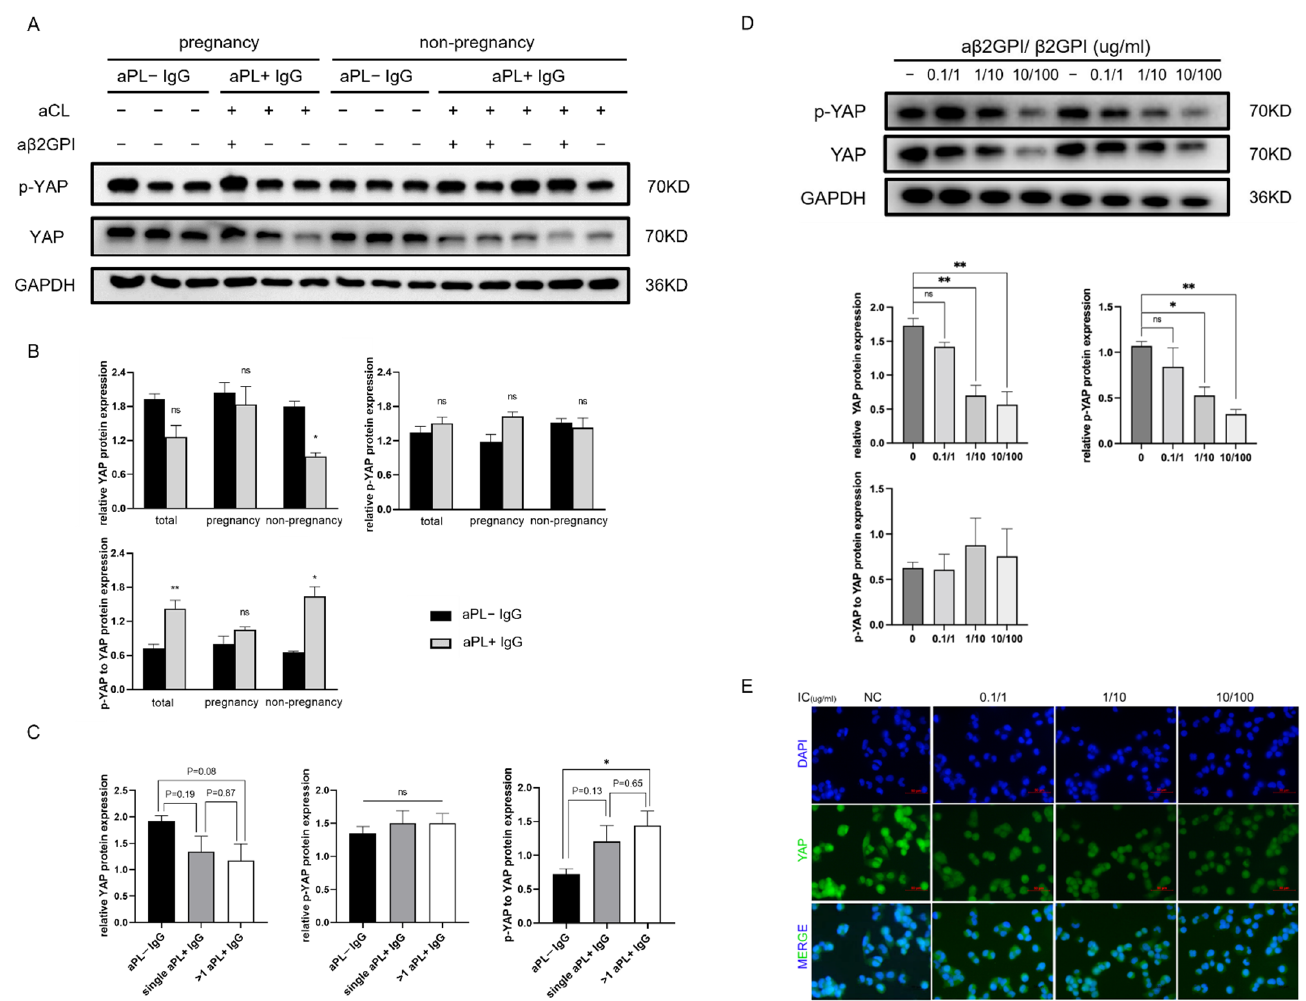
Figure 1. aPL-positive IgG affects YAP expression and nuclear localization in HTR-8 cells. aPL+ IgG was extracted from serum aPL-positive women carriers with pregnancy morbidity history and aPL − IgG from normal women for comparison. ( A ) YAP and phospho-Ser 127 YAP in HTR-8 cells treated with aPL − IgG (100 μ g/mL) and aPL+ IgG (100 μ g/mL) for 24 h were immunoblotted. Subgroup analysis was performed based on pregnancy status ( B ) and single or more aPL+ IgG ( C ). Single aPL+ IgG indicated that only aCL IgG or anti- β 2GPI IgG was positive. More than one aPL+ IgG indicated both aCL IgG and anti- β 2GPI IgG positivity. The anti- β 2GPI-IgG monoclonal antibody and human β 2GPI (anti- β 2GPI-IgG/ β 2GPI) complex was also prepared. ( D ) The anti- β 2GPI-IgG/ β 2GPI complex suppressed YAP expression of HTR-8 cells in a dose-dependent manner, with concentrations ranging from 0.1/1 to 10/100 μ g/mL with a binding ratio of 1:10. Quantitation of total YAP and p-YAP levels from blots (normalized to GAPDH) are shown as the mean± SEM ( B – D ). Mann–Whitney U test; ns indicates no significance, * p < 0.05, ** p < 0.01. ( E ) Incubation with the anti- β 2GPI-IgG/ β 2GPI complex for 6 h caused cytoplasmic retention of YAP in HTR-8 cells. The cellular distribution of YAP was shown with representative immunostaining images of HTR-8 cells after 6 h of exposure to different concentrations of anti- β 2GPI-IgG/ β 2GPI. Scale bars, 50 μ m. NC, control; IC, anti- β 2GPI-IgG/ β 2GPI complex.